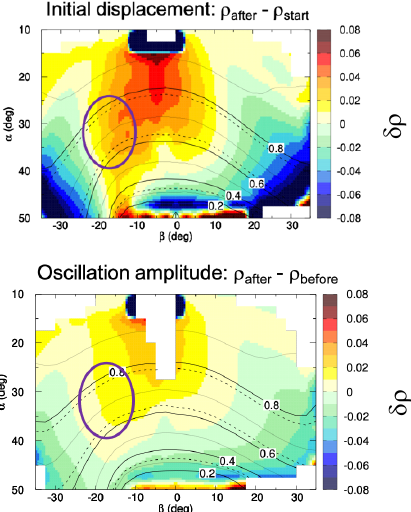
Fig. 8 . Displacement dr of the ECCD location due to n e modifications due by pellets varying toroidal and poloidal angles for pellets of 1.3 mm (top: between the case just after pellet and without pellet, bottom: between the case just after pellet and just before pellet). Black contours: reference ECCD location (before pellet injection). Dashed lines represent the rational q surfaces (R=2.14 m configuration). Violet ellipse highlights the optimized intervals of injection angles which reach the rational q surfaces 2 and